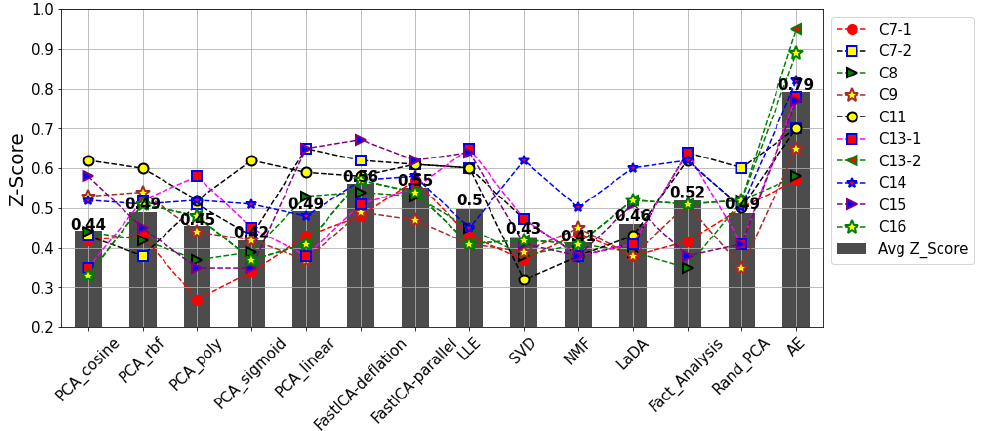
Figure 9. Z scores for the HIs generated by the respective fusion algorithms on the 10 datasets. The black bars ( AvgZ _ Score is the mean value of the Z scores for the 10 datasets per fusion